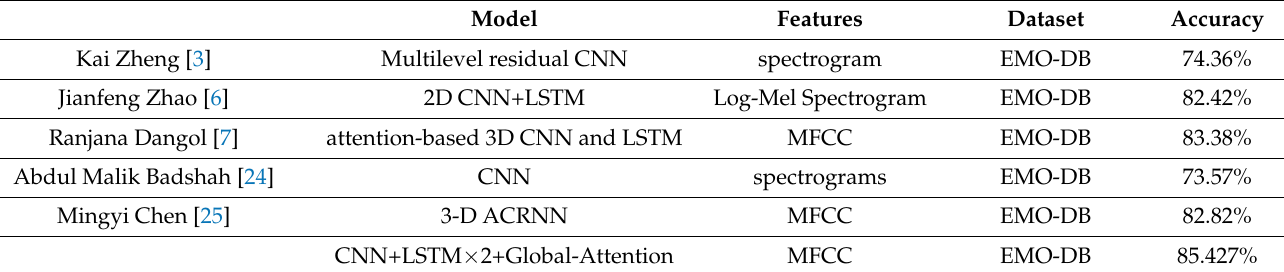
Table 4. The accuracy of the CNN+LSTM × 2+global-attention compared to other